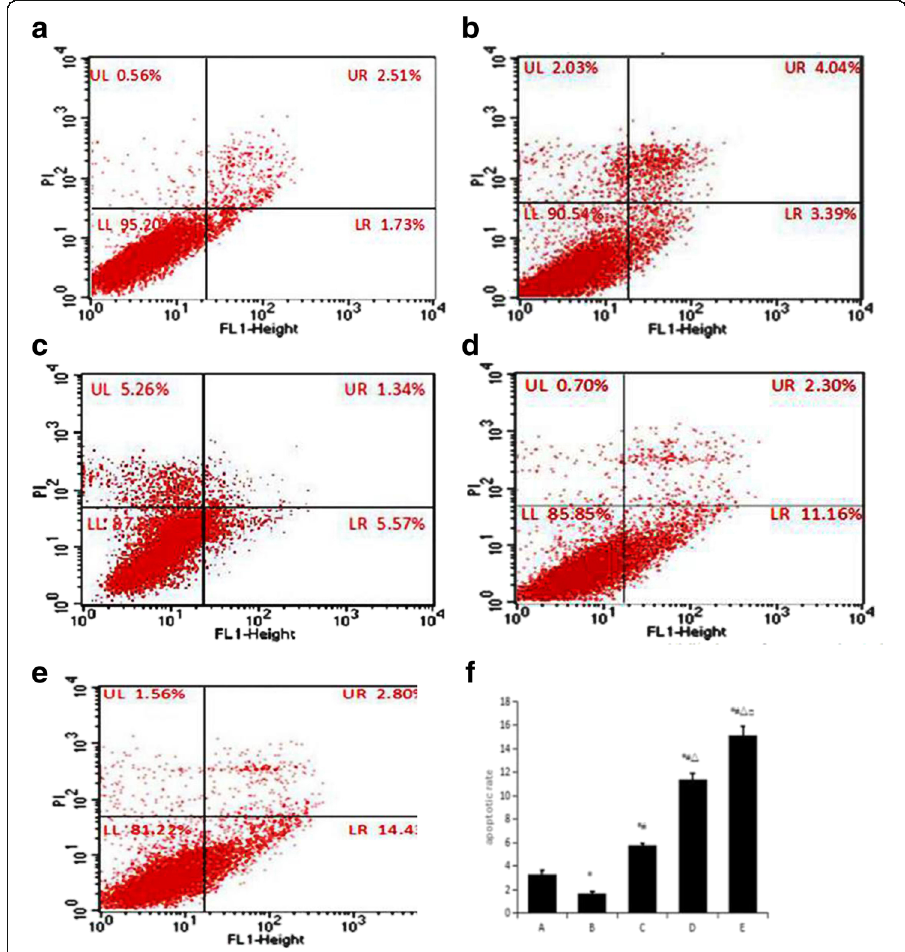
Fig. 1 Flow cytometry scatter plots and histogram plot of different treatments leading to apoptosis of rat hepatic stellate cells. a – blank group; b – TGF- β 1 group; c – TGF- β 1 + low dose of calcium ionophore A23187 group; d – TGF- β 1 + middle dose of calcium ionophore A23187 group; e – TGF- β 1 + high dose of calcium ionophore A23187 group. f – Changes in HSC apoptosis rate in the different treatment groups ( x ±s) expressed as a percentage. Denoted A through E as above. * p < 0.05 compared to the blank group; △ p <0.05 compared to the TGF- β # p < 0.05 compared to the TGF- β 1 group; 1 +low dose of calcium ionophore A23187 group; □ p<0.05 compared to the TGF- β 1 +middle dose of calcium ionophore A23187